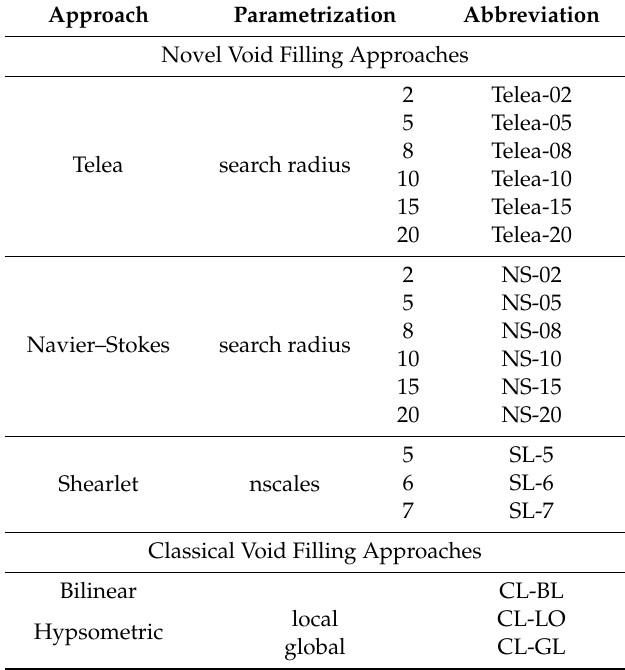
Table 1. Overview of applied void filling approaches and